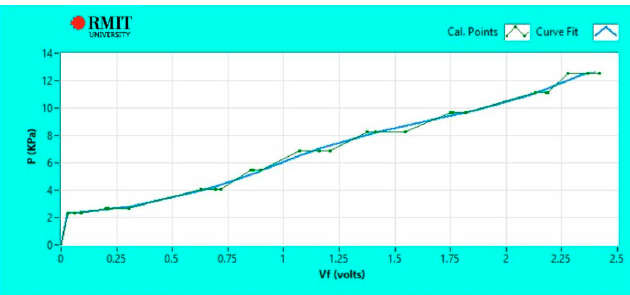
Figure 3. Calibration curve in LabView denoting the pressure-voltage relationship for the Figure Sensitronics sensor.